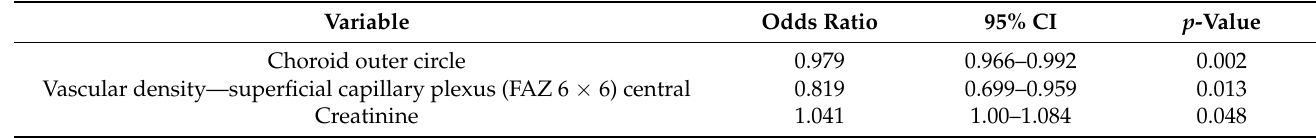
Table 3. Multivariate logistic regression to predict three vessel disease.